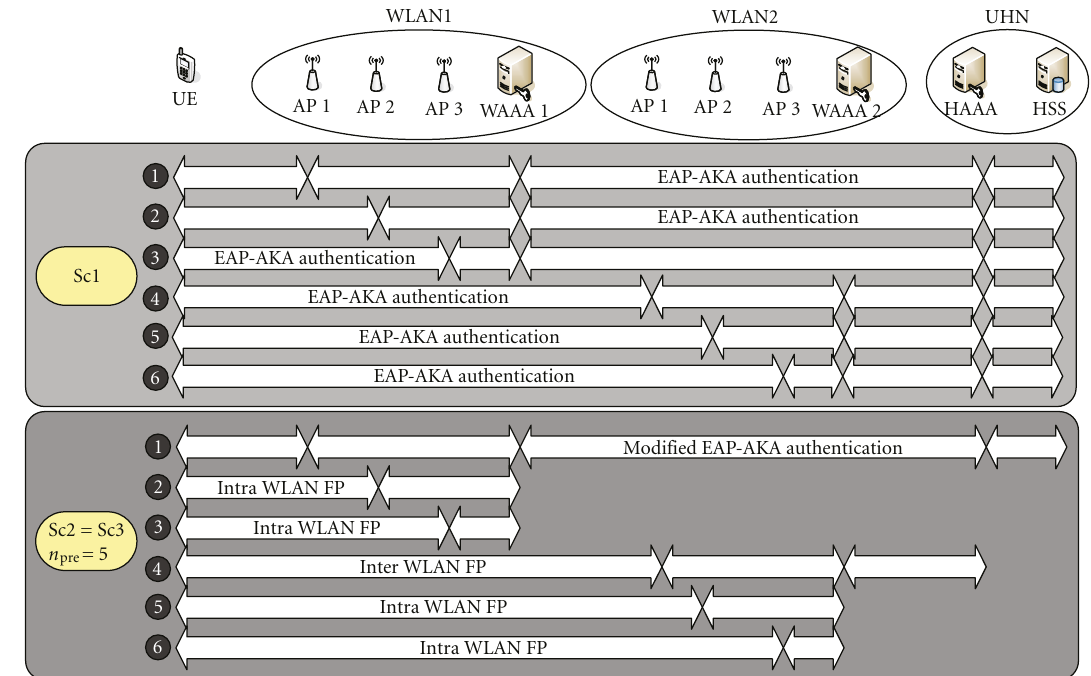
Figure 7: Authentication scenarios when n pre = 5.